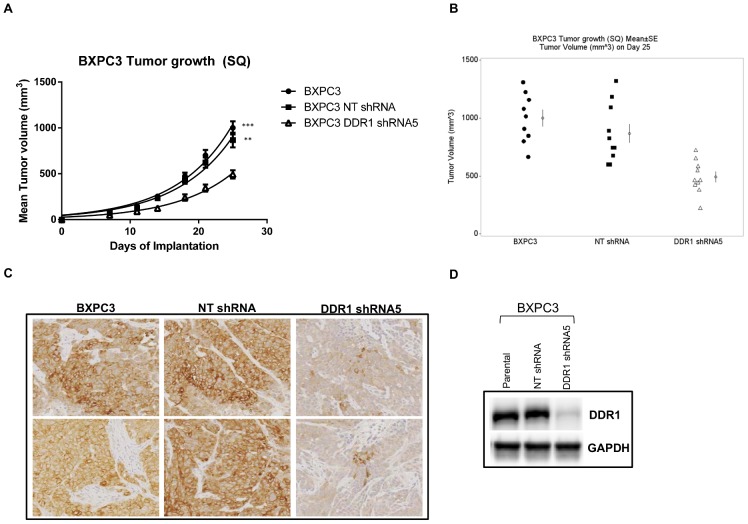
Efficacy of shRNA targeting DDR1 on BXPC3 tumor growth.(a) BXPC3 cells untreated (•), NT shRNA (▪) and DDR1 shRNA5 (Δ) were implanted in ICR-SCID mice and tumor growth was monitored up to 28 days. (b) On day 28, when compared to untreated and NT shRNA groups, the tumors in DDR1 shRNA5 group was the smallest as measured by the tumor volume (N = 10). The calculated percent inhibition in tumor growth in DDR1 shRNA group was 50.7% (***, p<0.0001) and 43.2% (**, p<0.0052) when compared to parental and NT shRNA groups, respectively. Tumors were harvested and DDR1 expression was confirmed by (c) immunohistochemistry and (d) western blot.